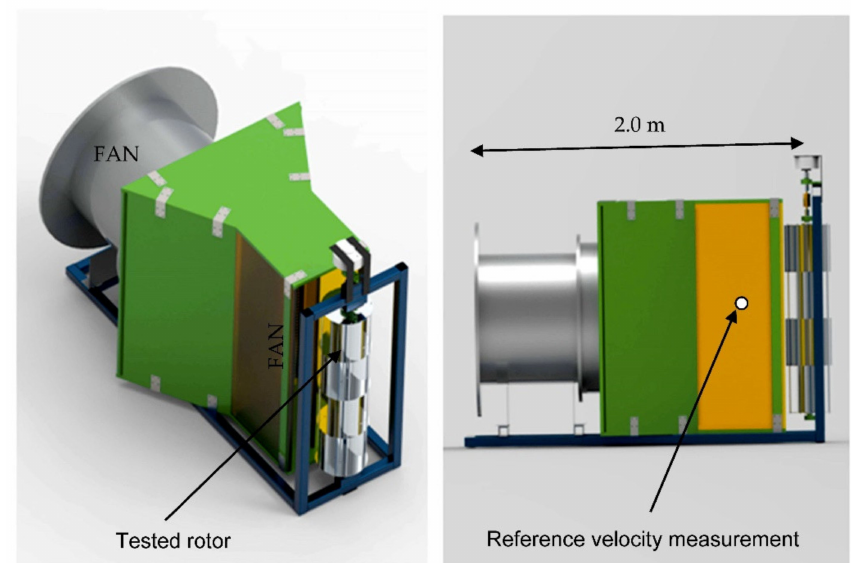
Figure 6. Experimental stand.